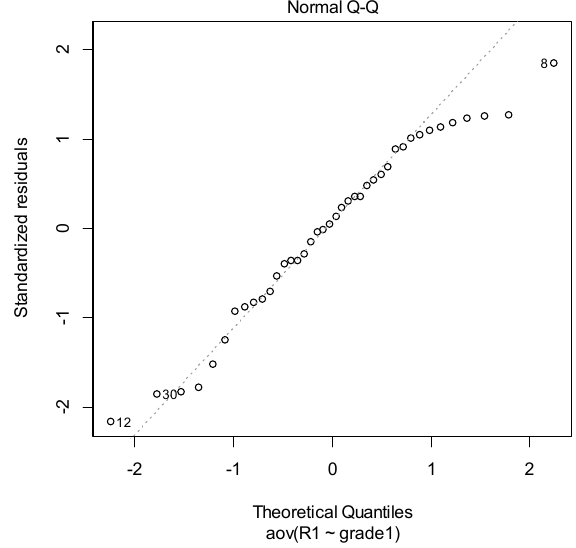
Figure 9. Q – Q plot from ANOVA in NEXTDENT case.